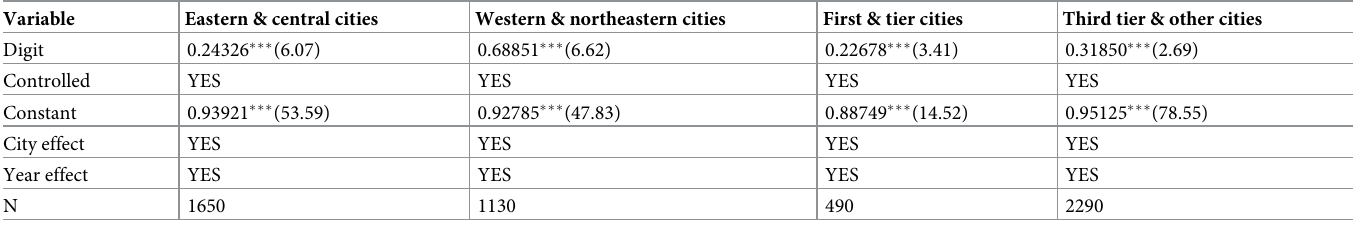
Table 6. Results of the heterogeneity